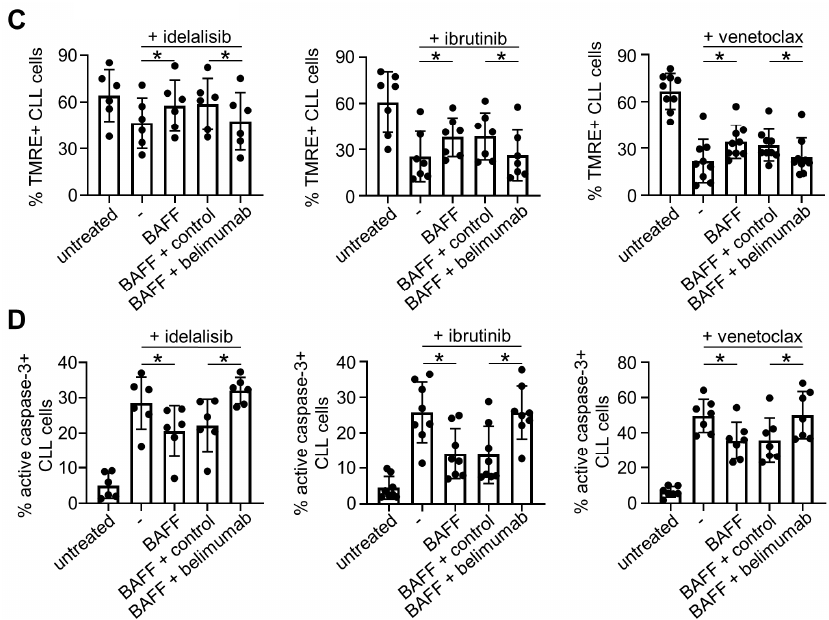
Figure 4. Neutralization of BAFF by belimumab re-sensitizes primary CLL cells to apoptosis induction by small molecule inhibitor treatment. Apoptosis in CLL cells was determined either by measurements of mitochondrial membrane potential with TMRE ( A,C ) or staining of active caspase-3 ( B,D ) using flow cytometry. ( A,C ) PBMC of CLL patients were incubated with idelalisib (10 µM, n = 6), ibrutinib (10 µM, n = 7) or venetoclax (5 nM, n = 9) in the presence or absence of rhBAFF (500 ng/mL), belimumab or control antibody (10 µg/mL each) followed by staining with CD3, CD5, CD19, 7-AAD and TMRE. Representative results in ( A ) are depicted for venetoclax showing the percentage of TMRE+ (= non-apoptotic) CLL cells, and combined results are shown in ( C ) for each small molecule inhibitor. For statistical analyses, a RM one-way ANOVA with Holm-Sidak’s multiple comparisons test was performed for idelalisib and ibrutinib, and Wilcoxon matched-pairs signed rank tests for venetoclax. ( B,D ) Activation of caspase-3 was analyzed in primary CLL cells exposed to idelalisib (50 µM, n = 6), ibrutinib (10 µM, n = 8) or venetoclax (7.25 nM, n = 7) in the presence or absence of rhBAFF (500 ng/mL), belimumab or control antibody (10 µg/mL each). Cells were stained with CD3, CD5, CD19, Fixable Aqua, an anti-active caspase-3 antibody and representative results are depicted in ( B ) as histograms, including the percentage of active caspase-3+ (= apoptotic) CLL cells and the isotype control signal (open histograms). Combined results are shown in ( D ). A paired t -test was performed for idelalisib, a Wilcoxon matched-pairs signed rank test for ibrutinib, and a RM one-way ANOVA with Tukey’s multiple comparisons tests for venetoclax. Statistically significant differences ( p < 0.05) are indicated by *.